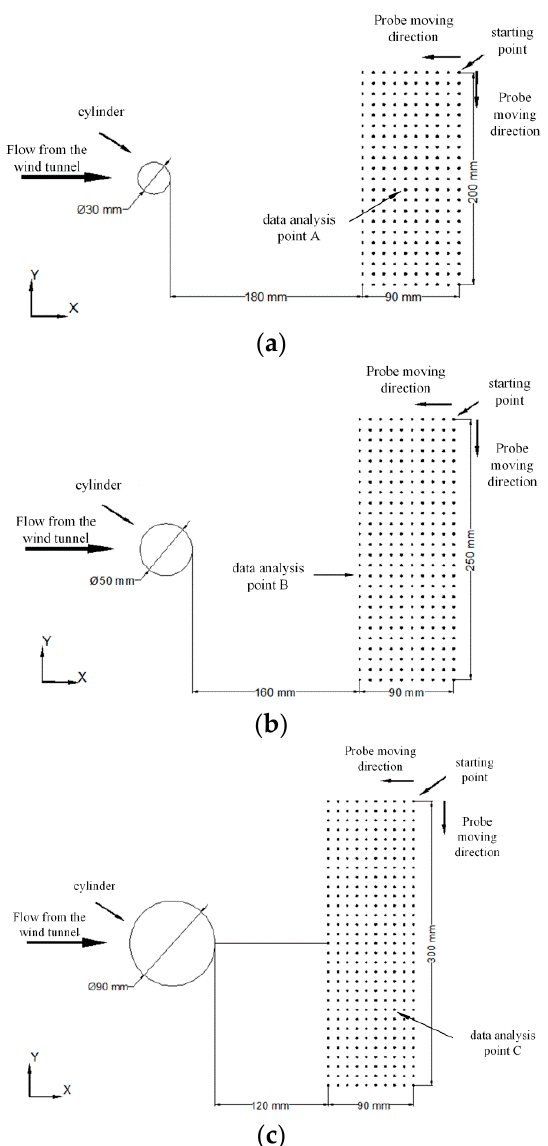
Figure 9. Distribution of test points for cylinders with different diameters. ( a ) 3 cm cylindrical test point. ( b ) 5 cm cylindrical test point. ( c ) 9 cm cylindrical test point.